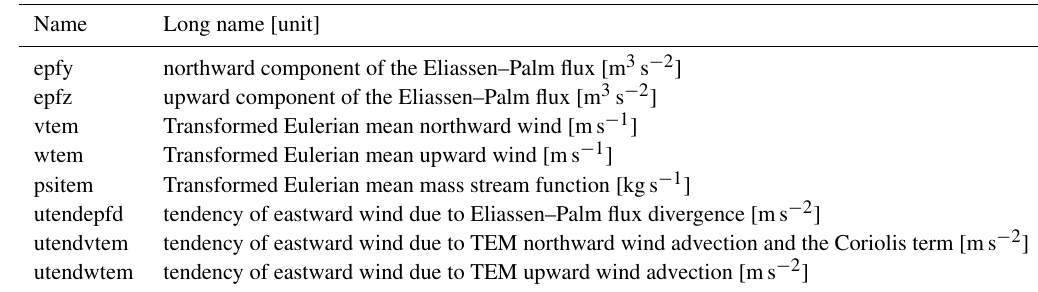
Table A1. Momentum budget variable list (2-D monthly / daily zonal means, YZT).